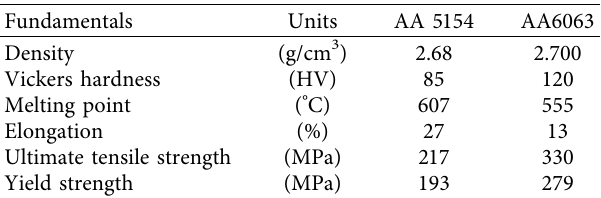
Table 2: Physical and mechanical characteristics of AA 5154 and